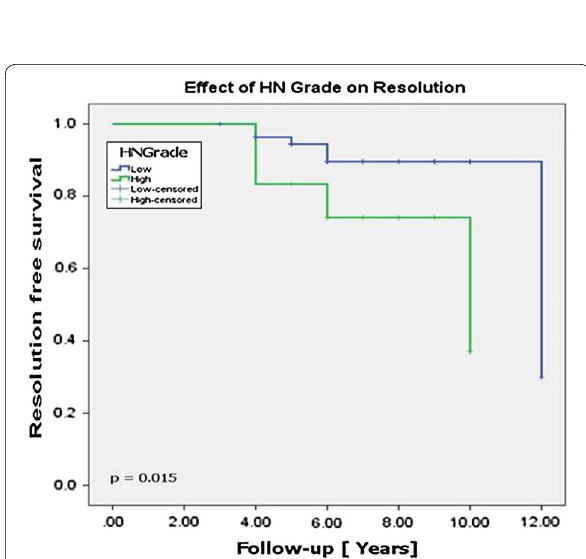
Fig. 2 Kaplan–Meier curve showing the incidence of VUR resolution stratifying by the DMSA split function